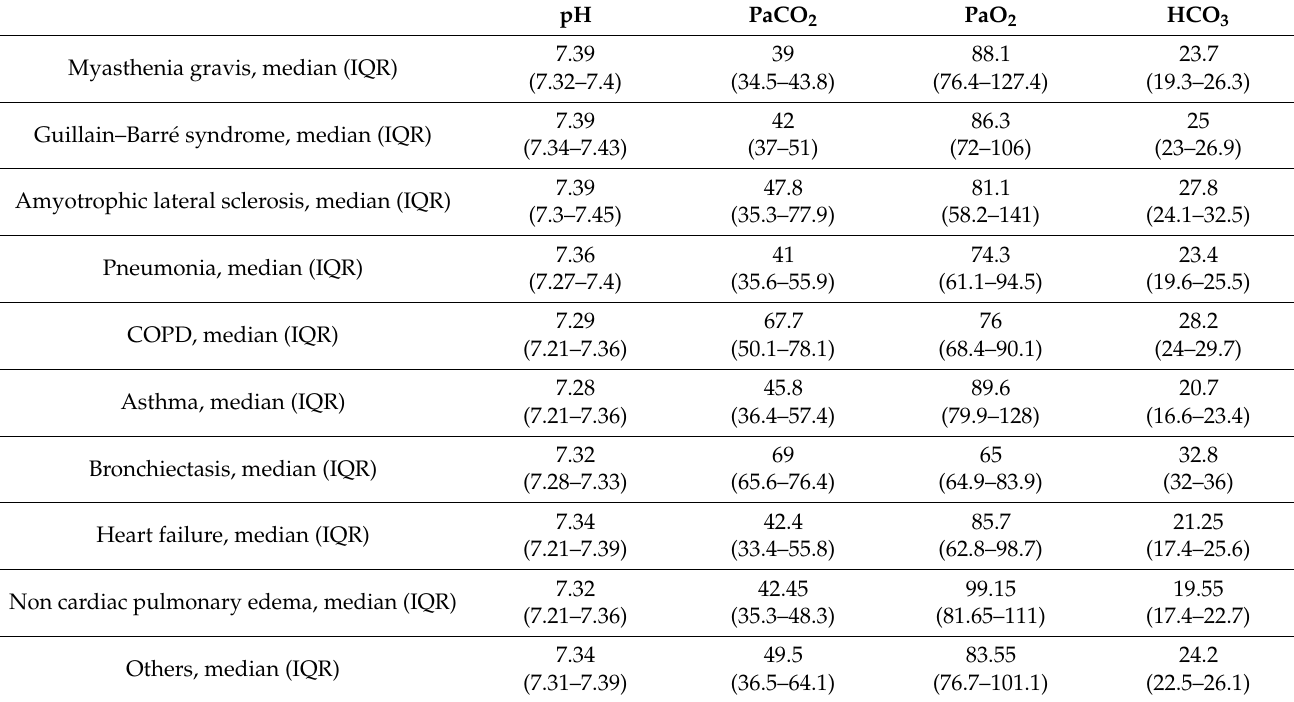
Table 3. Arterial blood gas parameters according to